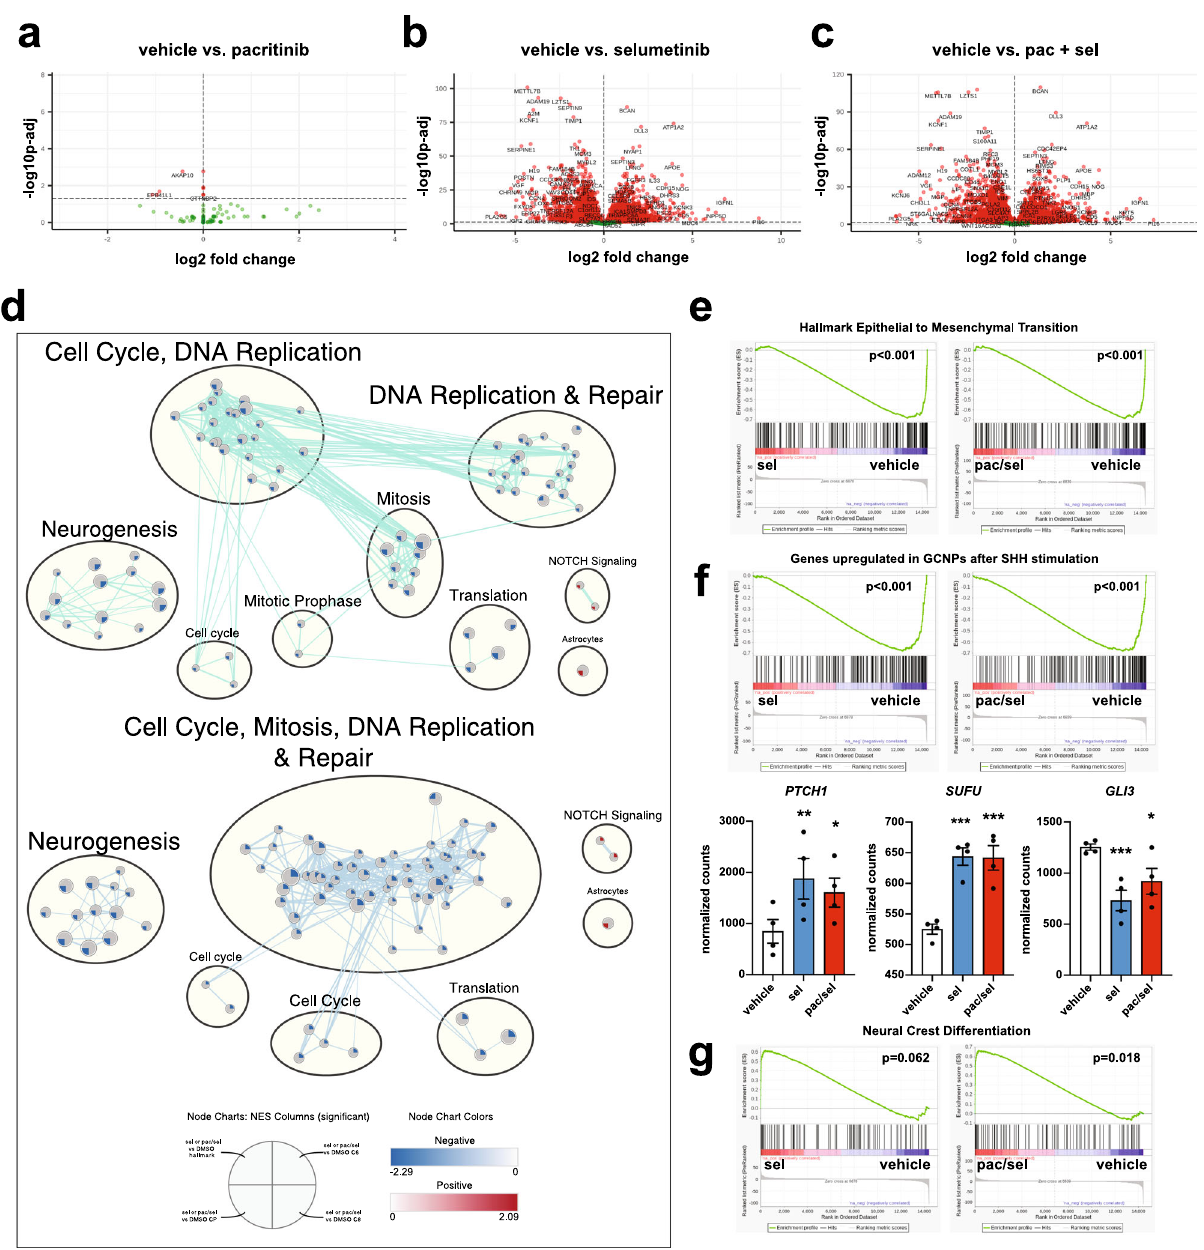
Fig. 5 MEK or MEK + JAK/STAT3 inhibition signi fi cantly alters the transcriptome of UI226 SHH MB-treated tumorspheres. Volcano plot depicting the log2 fold change and p-values in RNA-seq data comparing pacritinib ( N = 6 samples) ( a ), selumetinib ( N = 4 samples) ( b ) or pacritinib + selumetinib ( N = 4 samples) ( c ) to vehicle controls ( N = 4 samples) (FDR < 0.05). d Enriched pathways and biological processes as determined by GSEA following selumetinib (upper) or pacritinib + selumetinib (lower) treatment. GSEA results for Hallmark, Canonical Pathways (C2:CP), Oncogenic Signatures (C6), and Cell Type Signatures (C8) ( q -value <0.005) were used to build the enrichment map. Node coloring is based on the normalized enrichment score (NES), with blue representing enrichment in vehicle and red representing enrichment in selumetinib or pacritinib + selumetinib (NOTCH signaling and Astrocyte signature only). e Genes associated with epithelial to mesenchymal transition are enriched in gene sets that are downregulated in the selumetinib and pacritinib + selumetinib treated tumorsphere samples relative to vehicle controls. p < 0.001***. f GSEA (upper) and normalized counts (lower) depicting changes in genes associated with granule neural precursors cells following SHH stimulation (upper) or in speci fi c SHH signaling pathway genes (lower) following selumetinib or pacritinib + selumetinib treatment. For differentially expressed genes (lower), multiple testing correction was performed using the Benjamini Hochberg method, and genes identi fi ed using a q -value (i.e. a corrected p value) cut-off of 0.05. p < 0.05*, p < 0.01**, p < 0.001***. For PTCH1 : sel, p = 0.0082; pac/sel, p = 0.0235. For SUFU : sel, p = 2.21E-05; pac/sel, p = 2.92E – 05. For GLI3 : sel, p = 0.00079; pac/sel, p = 0.04567. g Genes associated with neural crest differentiation are enriched in gene sets that are upregulated in the pacritinib + selumetinib treated samples relative to vehicle